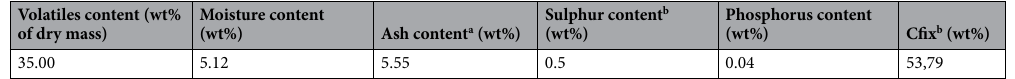
Table 2. A proximate composition of bituminous coal used for preparation of activated carbon. a Ash content of the coal considered as the candidate material for manufacturing of AC is shown in the Table 2. b Fixed carbon content.